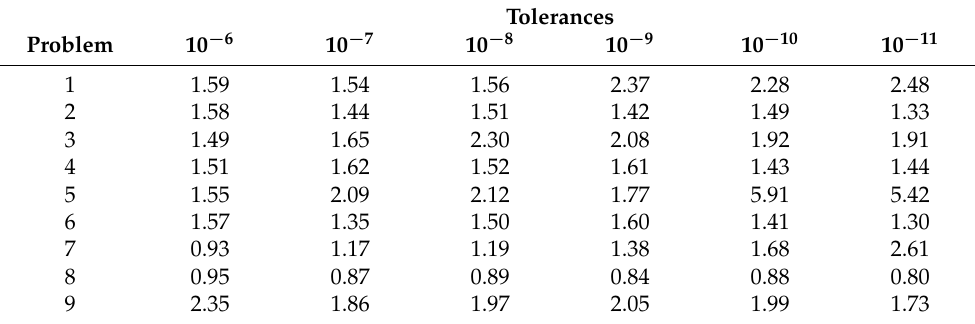
Table 4. Efficiency measures ratios of ST6(4) vs